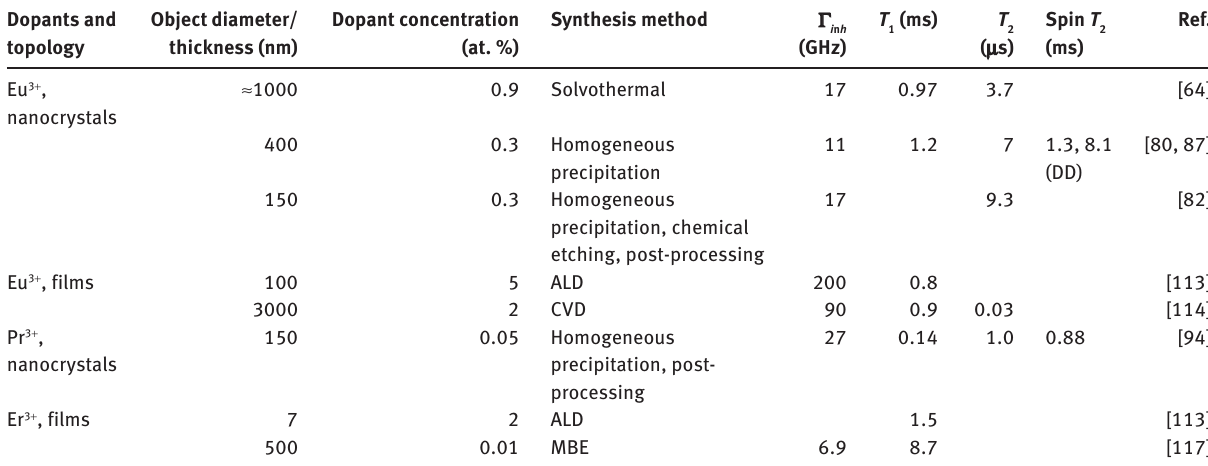
Figure 4: Photoluminescence of Er 3 + in an epitaxial Y on silicon using molecular beam epitaxy. (A) Two 4 I – 4 I optical transitions of Er confirm the correct crystal 13/2 15/2 symmetry site occupancy. The inset shows a transmission electron microscope image of the Y O lattice on silicon. (B) Measured 2 3